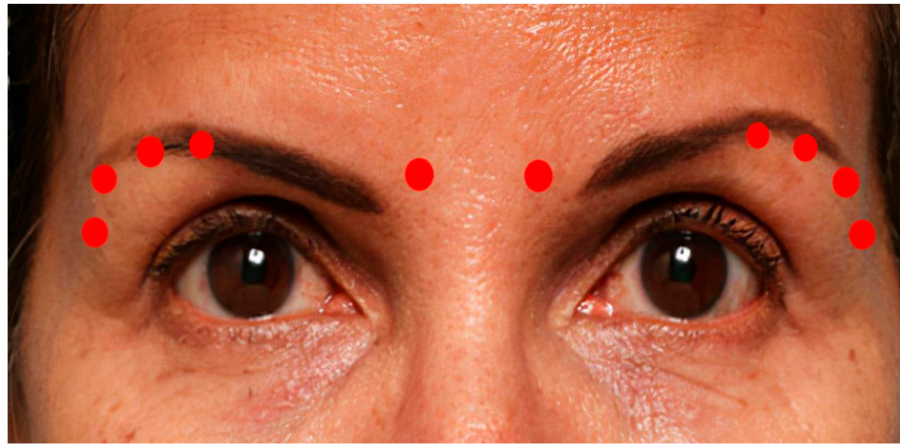
Figure 7. The red dots approximate the placement of botulinum toxin injections [52].